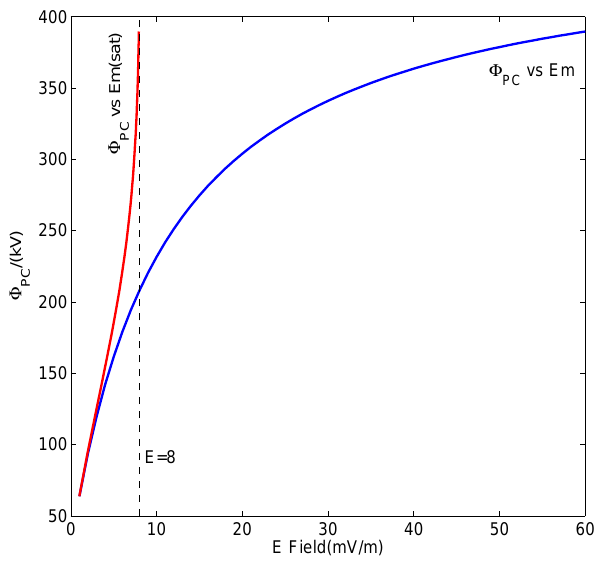
Fig. 1. The relation between the transpolar potential of 8 PC and the merging electric field E m . 8 PC is calculated using the method described in Ober and Maynard (2003). The blue curve shows that 8 PC saturates when E m increases, while the red curve shows a al- most linear relation between 8 PC and E m ( sat ) .